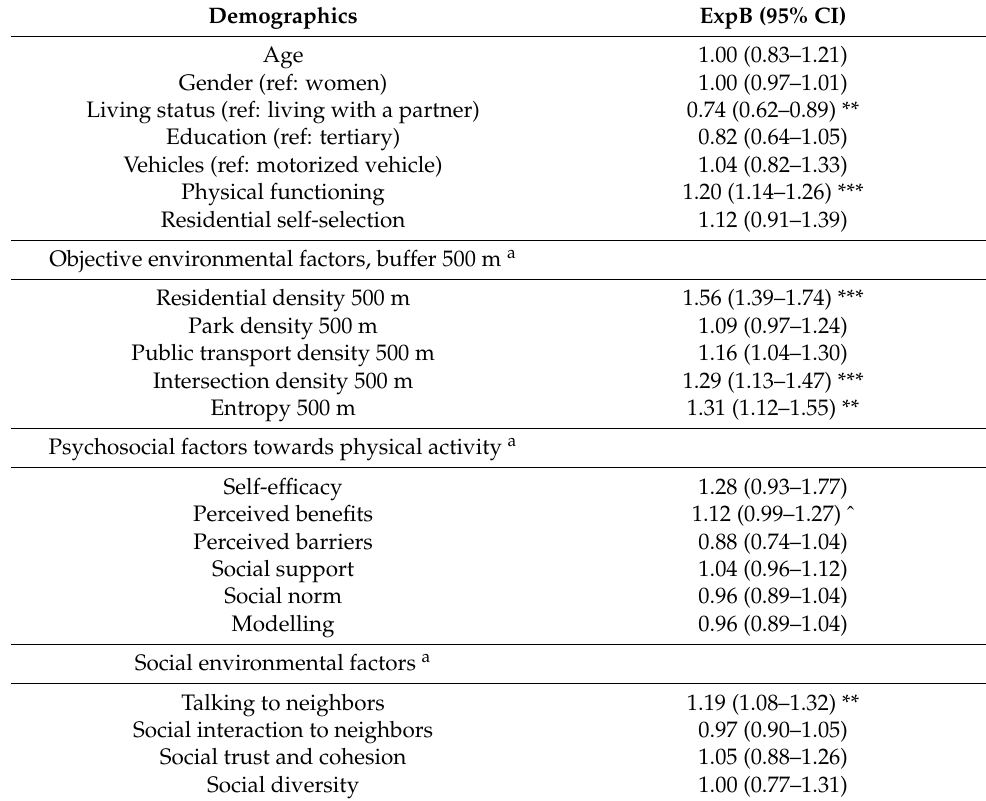
Table A1. Single-predictor models related to active transport.